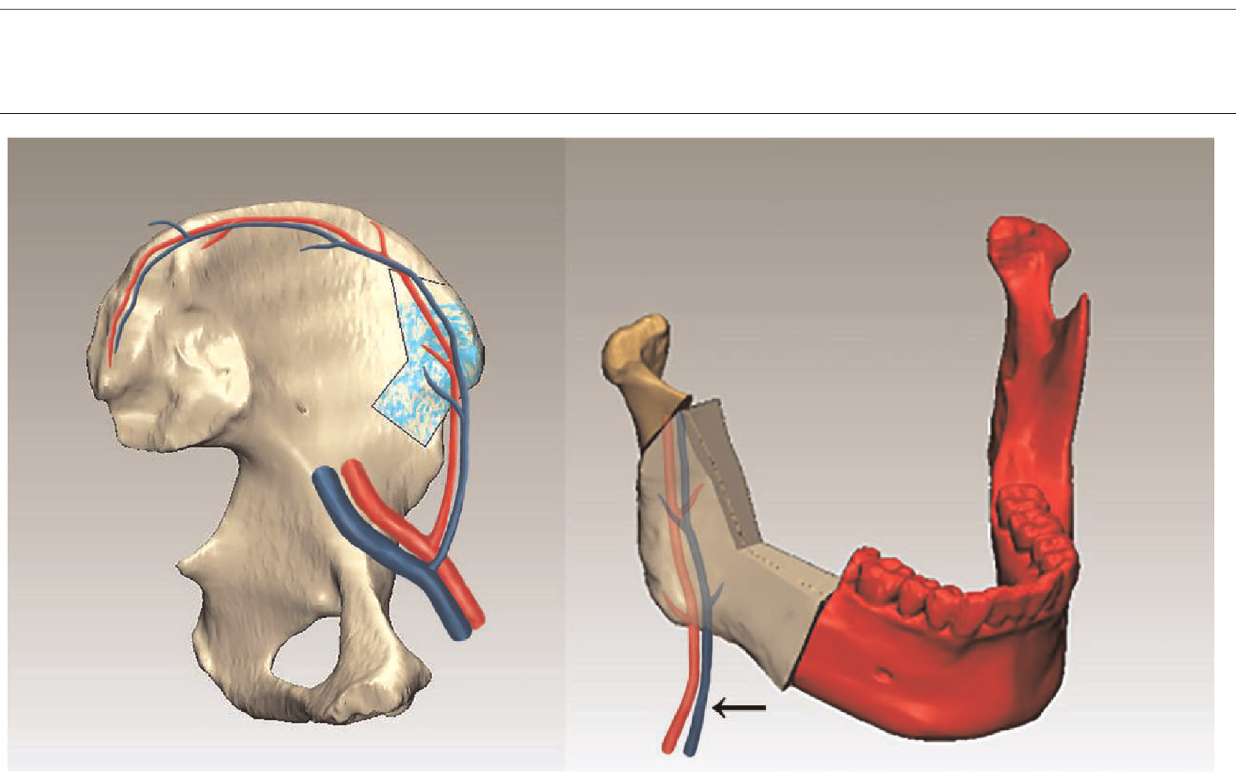
FIGURE 6 | Lateral views showing that the facial incision healed well: ( A – C ) postoperative, 1 week, and 7 years after operation; postoperative function and facial appearance recovered well ( D,E ).